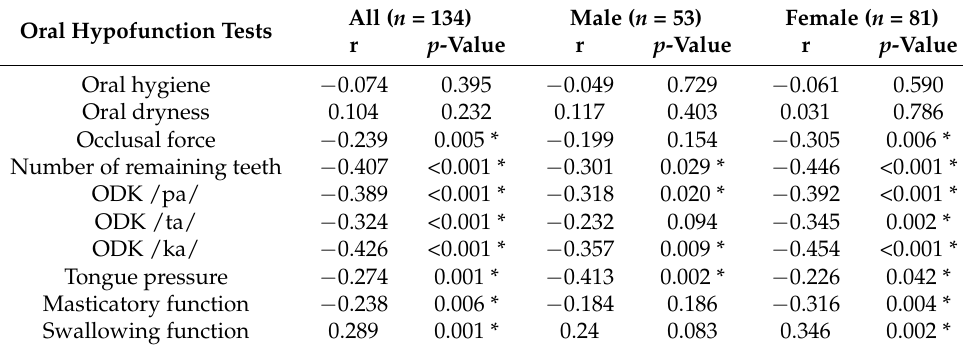
Table 3. Correlation analysis between oral hypofunction tests and age.